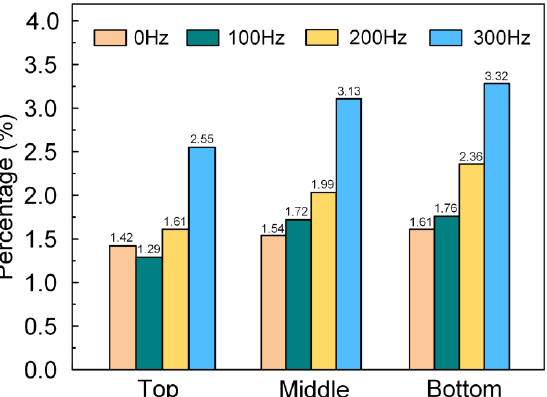
Figure 9. Columnar statistics of precipitate content at various positions from 0 Hz to 300 Hz. Table 3. The EDS results for different microstructures in thin-walled components.